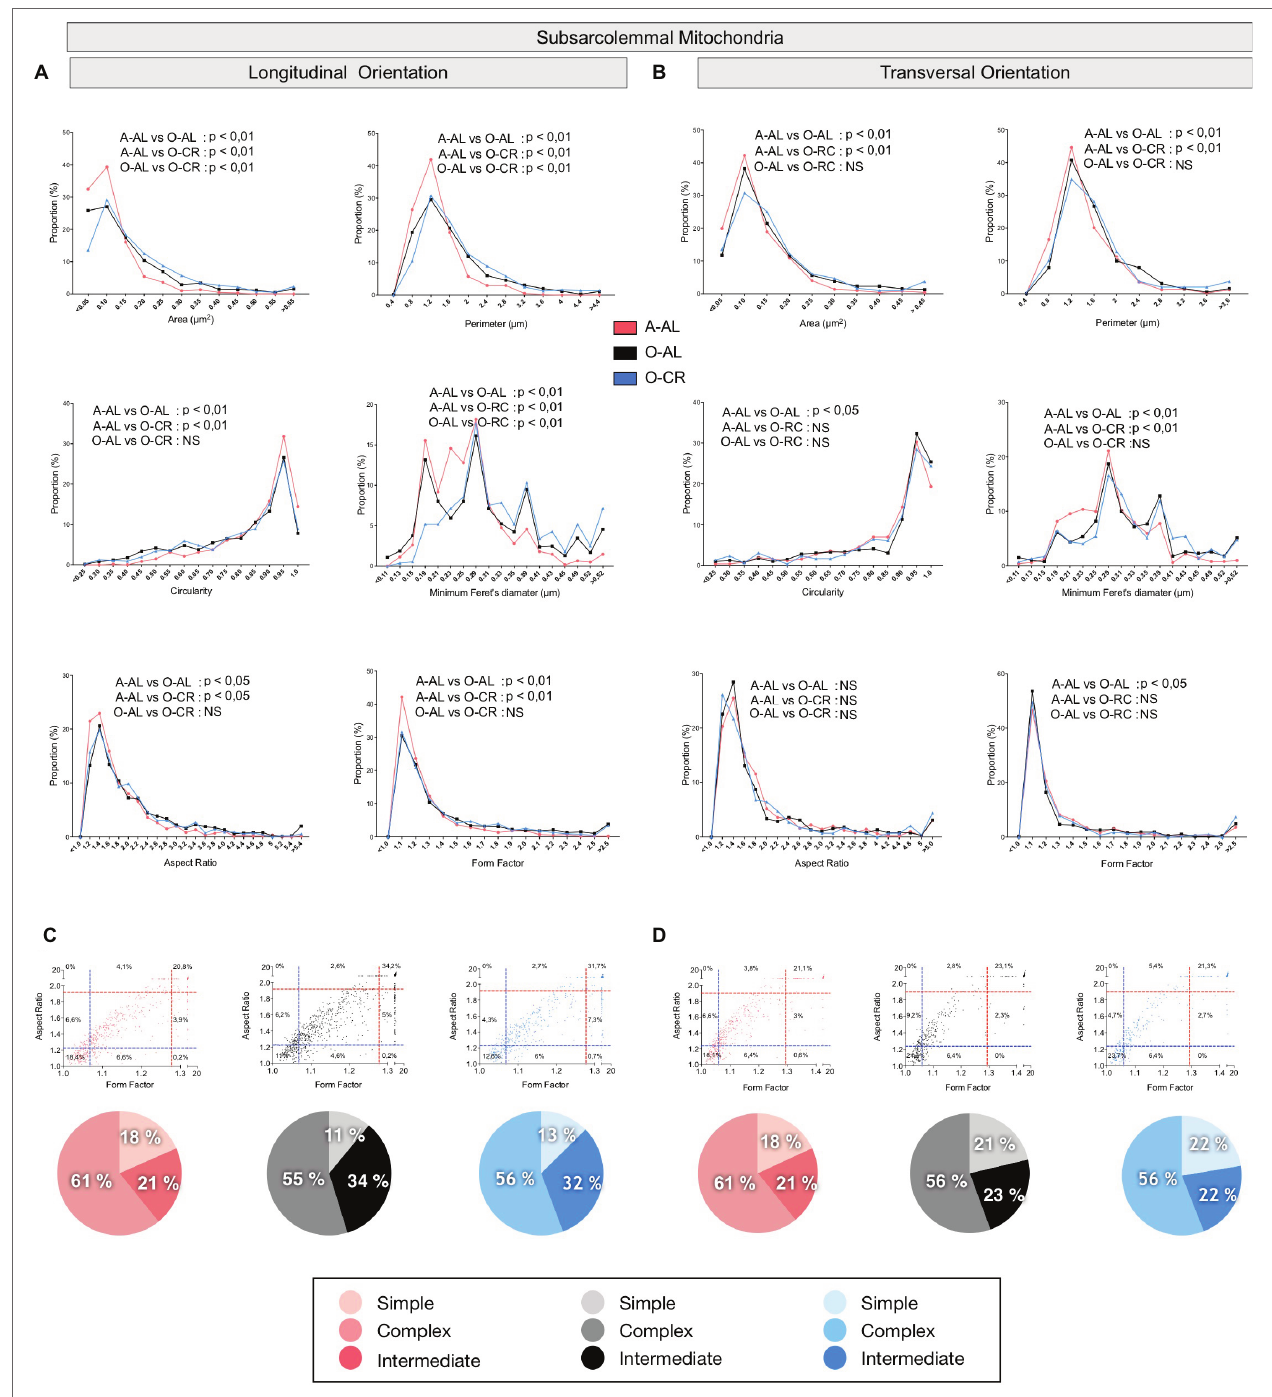
FIGURE 6 | Effect of aging and caloric restriction on the morphology of subsarcolemmal (SS) mitochondria in the glycolytic white gastrocnemius (WG) muscle. Analyses of morphological parameters of mitochondria SS in WG muscle (longitudinal and transversal orientation). (A) and (B) Frequency distribution of shape descriptors and morphological for SS mitochondria in longitudinal (A) and transversal orientations (B) . (C) and (D) display the form factor and aspect ratio relationship for individual SS mitochondria for A-AL (left graph), O-AL (middle graph) and O-CR (right graph) rats in longitudinal (C) and transversal orientations (D) . In (C) and (D) , blue and red dashed lines represent the 25th and 75th percentiles for either aspect ratio or form factor values of A-AL, respectively. The pie charts in the second line represent the percentage of mitochondria with simple (i.e. mitochondria with aspect ratio and form factors values inferior to the 25th percentile of A-AL values), complex (i.e. mitochondria with aspect ratio and form factors values above the 75th percentile of A-AL values) and intermediate (i.e. neither simple nor complex). Differences in frequency distributions were tested using a Kolmogorov–Smirnov test comparing cumulative